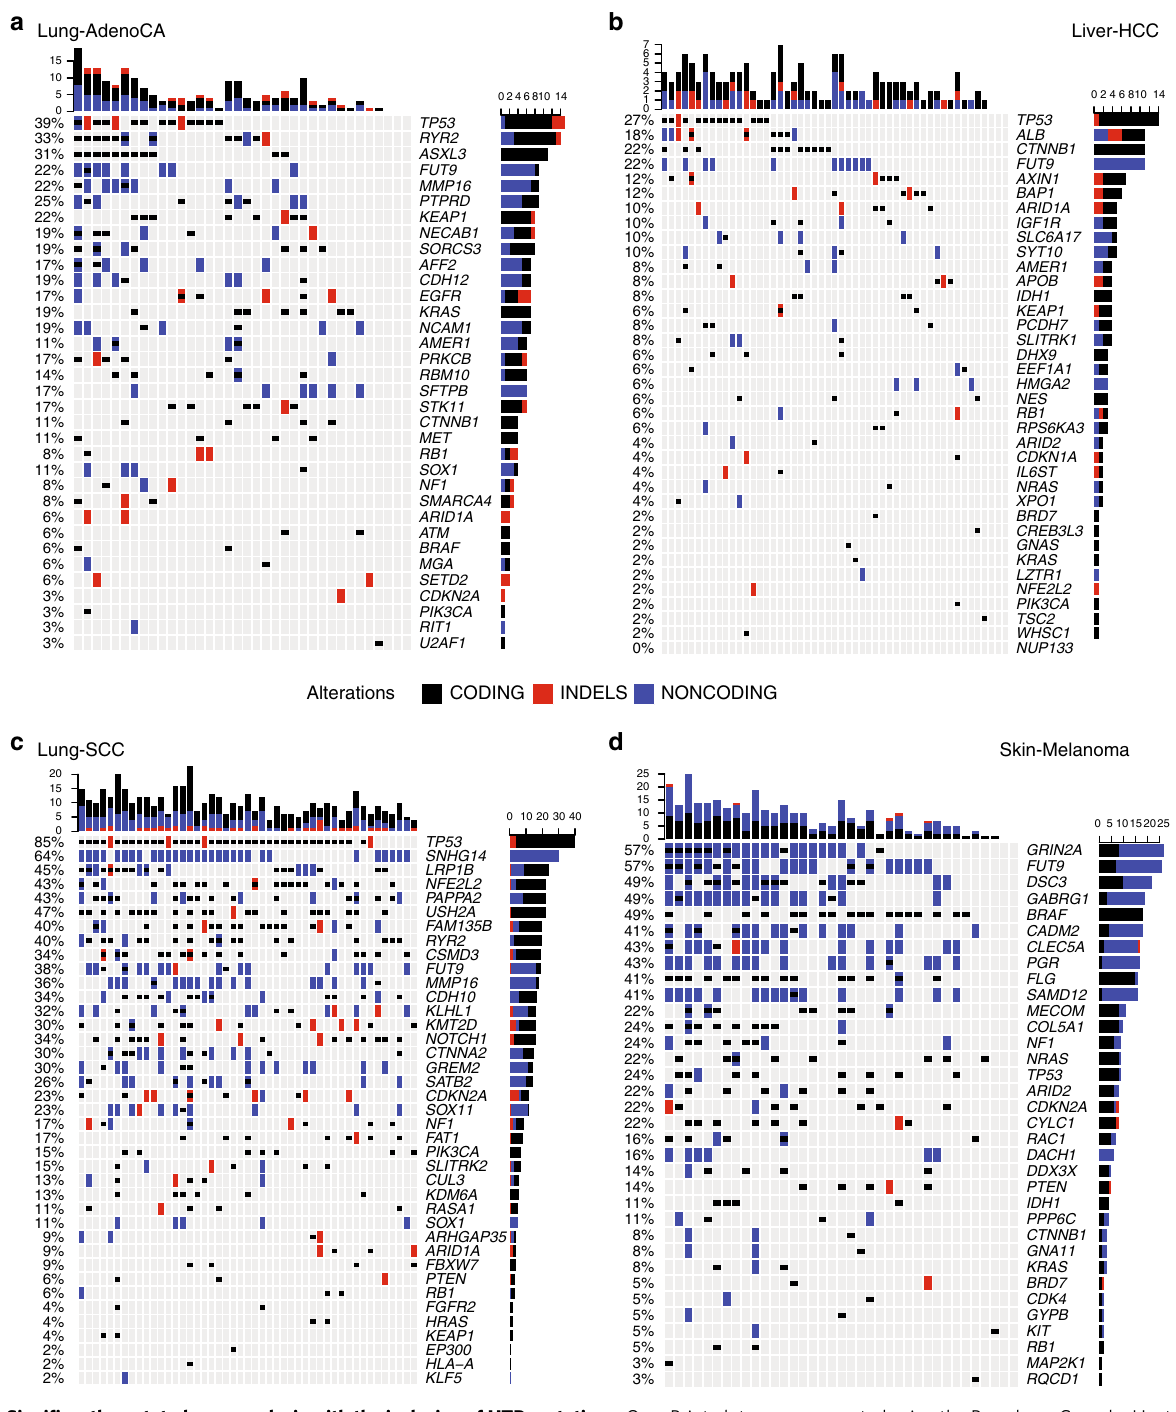
Fig. 6 Signi fi cantly mutated gene analysis with the inclusion of UTR mutations. OncoPrint plots were generated using the R package ComplexHeatmap 42 for four cancer types: LUAD ( a ), LIHC ( b ), LUSC ( c ), and SKCM ( d ). We report all SMGs identi fi ed by Bailey et al. 2018 28 , as well as top signi fi cantly mutated gene hits from MuSiC that include non-coding mutations. While many non-coding mutations look promising, further investigation yielded little support for driver identi fi cation